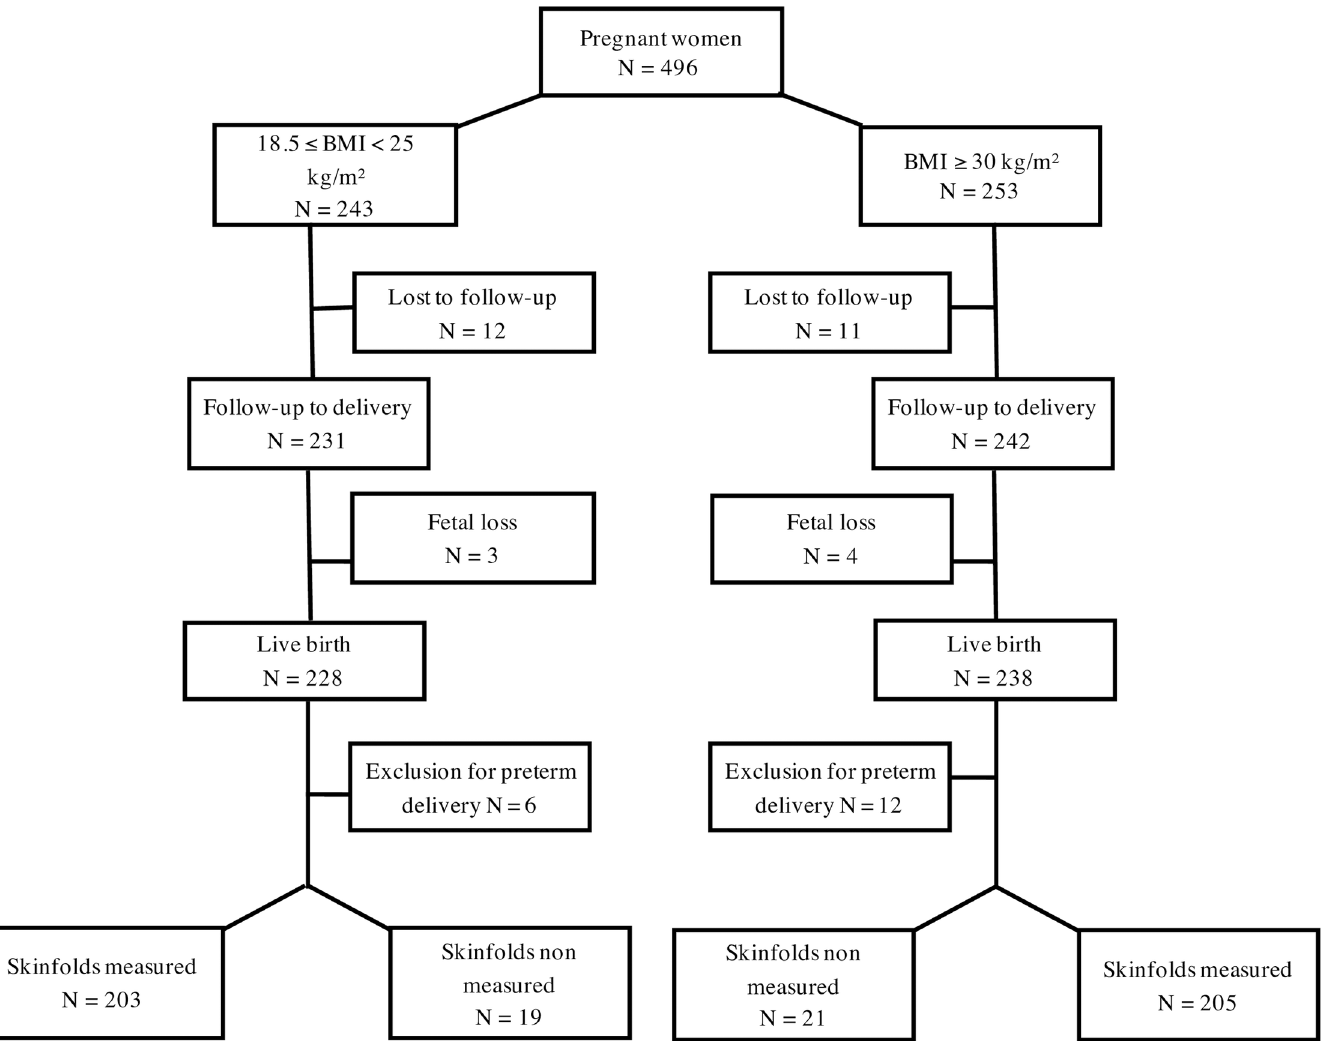
Fig 1. Flow chart of the study. Fetal losses in the group of women of normal weight were due to one termination of pregnancyfor growth restriction and two fetal deaths; fetal losses in the group of women with obesity were due to one miscarriage, two terminationsof pregnancyfor neuraltube defect and corpus callosumagenesisand one fetal